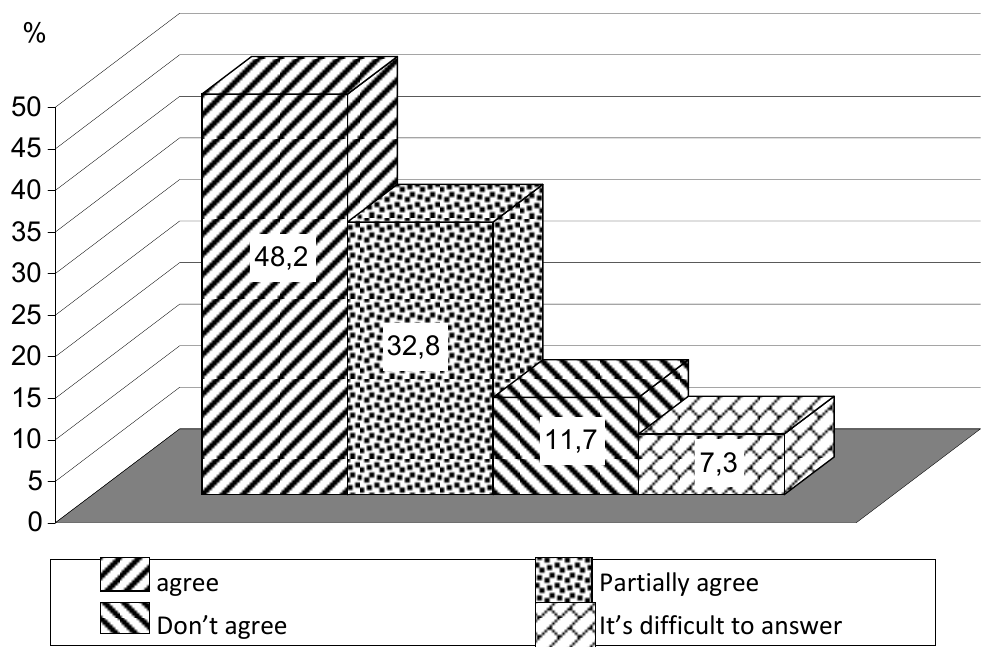
Fig.1. Quantity of students, questioned about staff provisioning for valueology functioning in CEE.